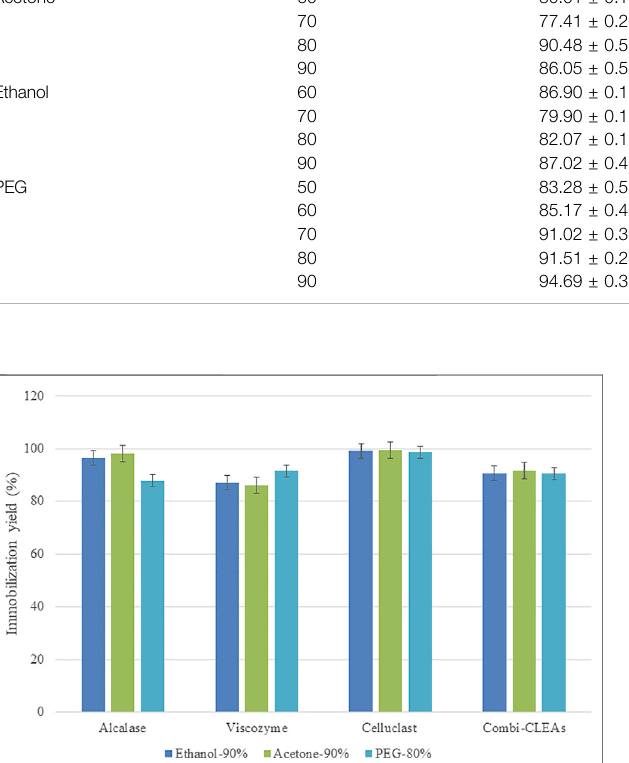
FIGURE 5 | Immobilization performance of CLEAs and combi-CLEAs at best precipitant conditions.